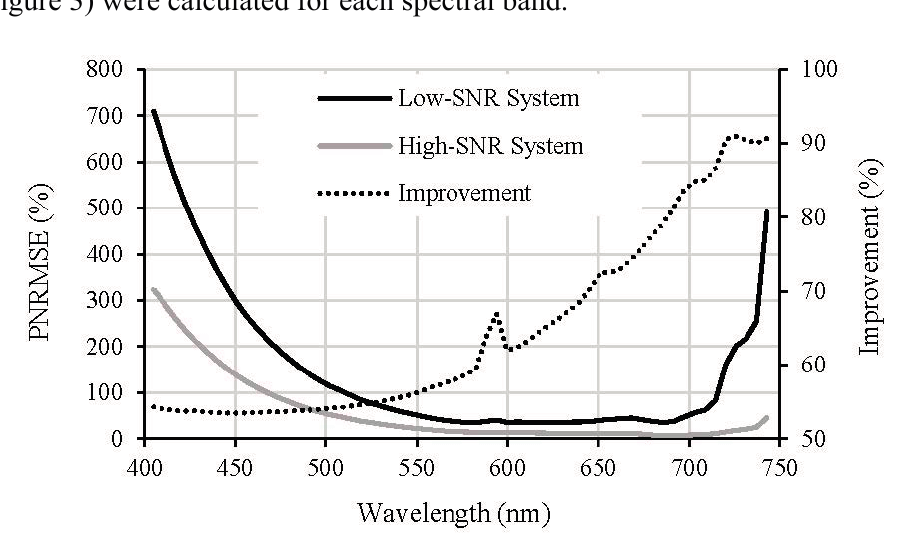
Figure 3. The average PNRMSEs of the atmospherically corrected R rs spectra from the 490 images for the low- and high-SNR systems and the percent improvement (on the secondary axis) in the variations in R rs when the F-number is changed from 3.5 to